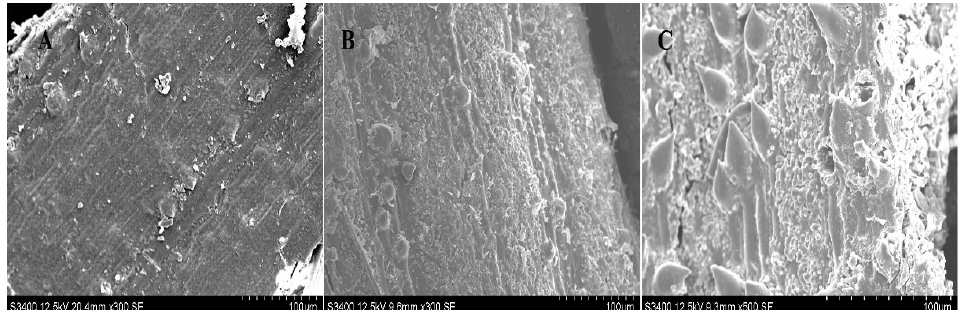
Figure 8. SEM of raw Paecilomyces hepiali powder before treatment ( A ), and after hot water extraction ( B ), and DES extraction ( C ), with magnification at 500× at 12.5 kv.